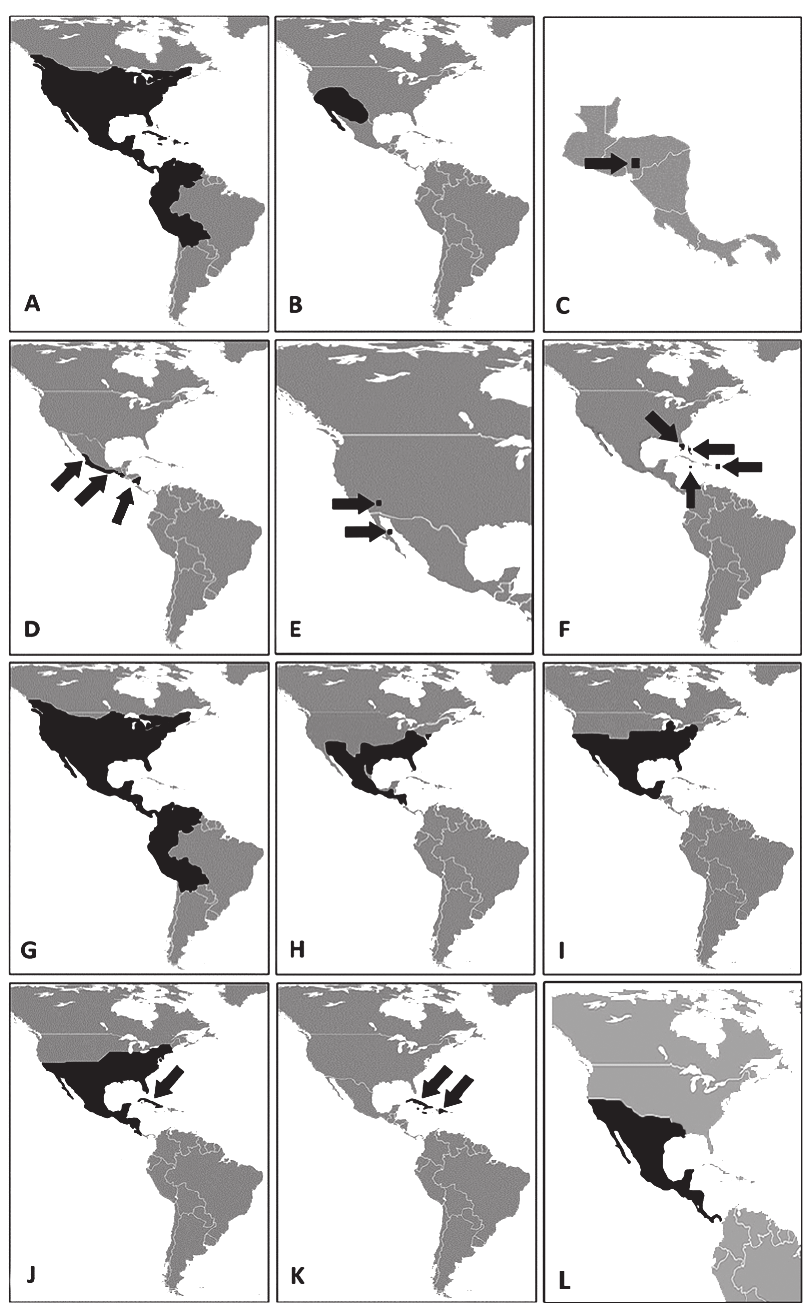
Figure 21. Distribution in the New World of: A Tillinae Leach B Araeodontia Barr C Barrotillus Rif- kind D Bogcia Barr E Bostrichoclerus Van Dyke F Callotillus Wolcott G Cymatodera Gray (not treated here) H Cymatoderella Barr I Lecontella Wolcott & Chapin J Monophylla Spinola K Onychotillus Chapin L Neocallotillus